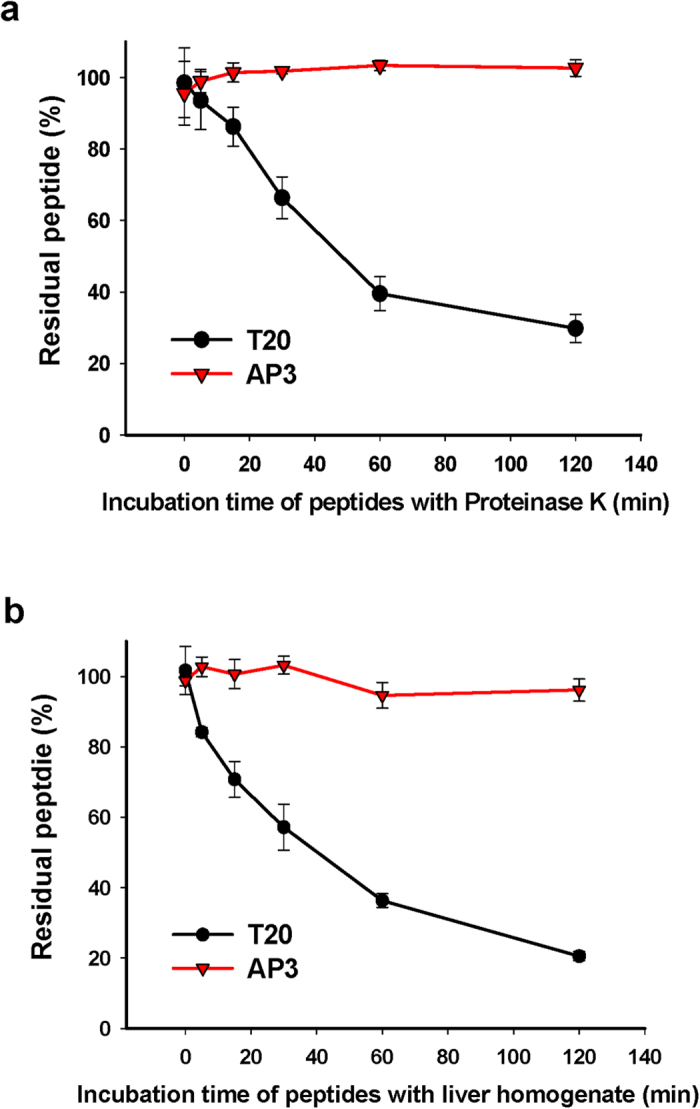
Sensitivity of AP3 and T20 to proteolytic degradation by proteinase K and rat liver homogenate.(a) After digestion by proteinase K at pH 7.2 and (b) rat liver homogenate, the residual amount of AP3 and T20 was detected by LC-MS analysis. The experiment was performed in triplicate and the data are presented as means ± SD.